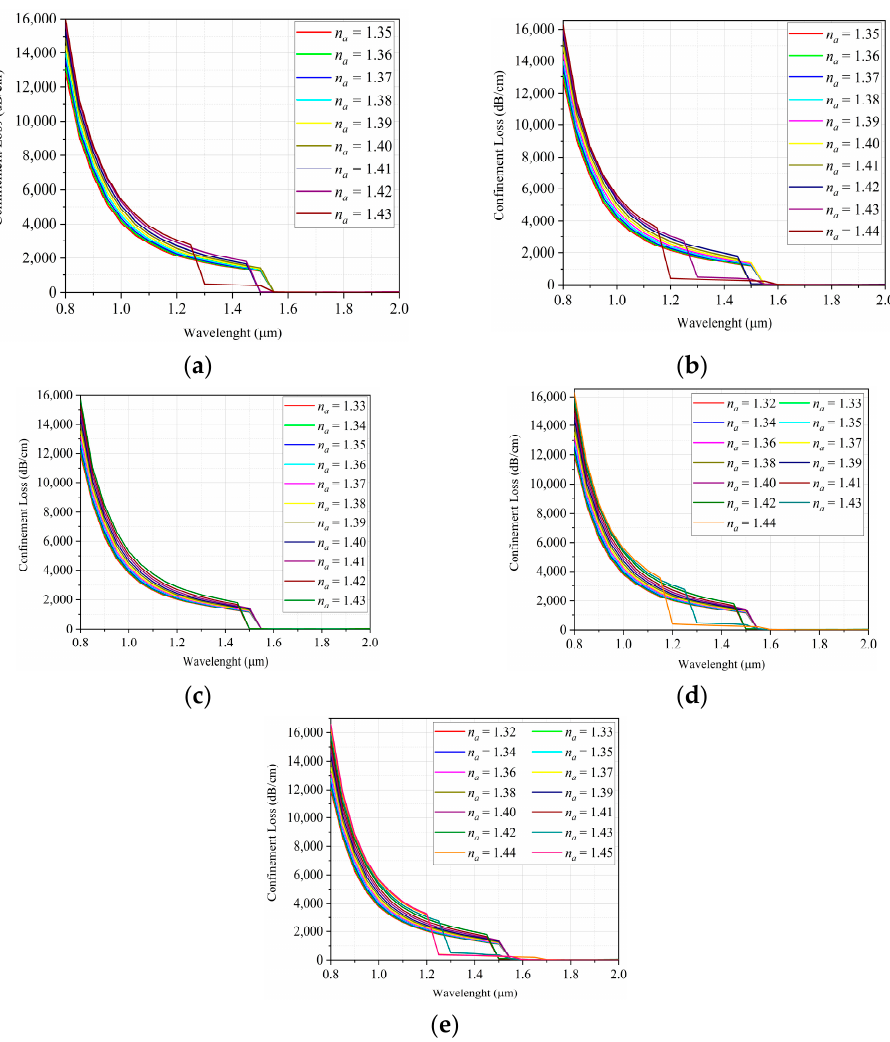
Figure 8. Confinement loss versus wavelength, considering the defect: ( a ) without doping; ( b ) doped with GeO 2 ( 4.1% ) ; ( c ) doped with GeO 2 ( 6.3% ); ( d ) doped with GeO 2 ( 13.5% ) ; ( e ) doped with GeO 2 ( 19.3% )